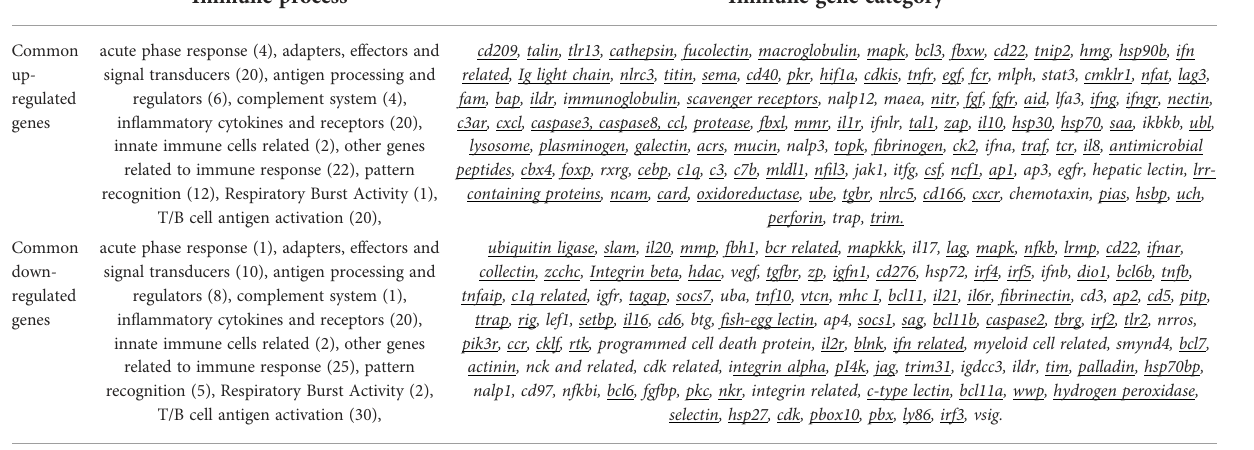
Genes marked by solid lines represent CK vs D3, genes marked by dashed lines represent CK vs D7, and genes marked by double solid lines represent CK vs D3 and CK vs D7.